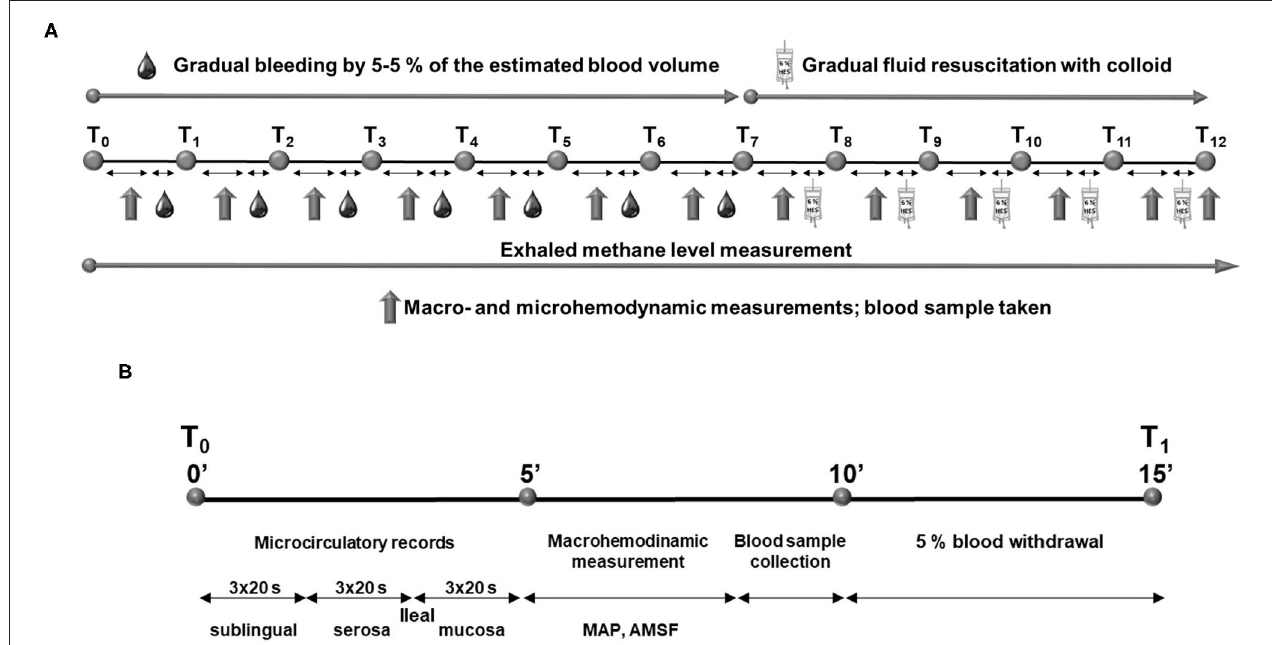
FIGURE 1 | Experimental protocol (A) and timeline of the measurement period during the experiment (B)